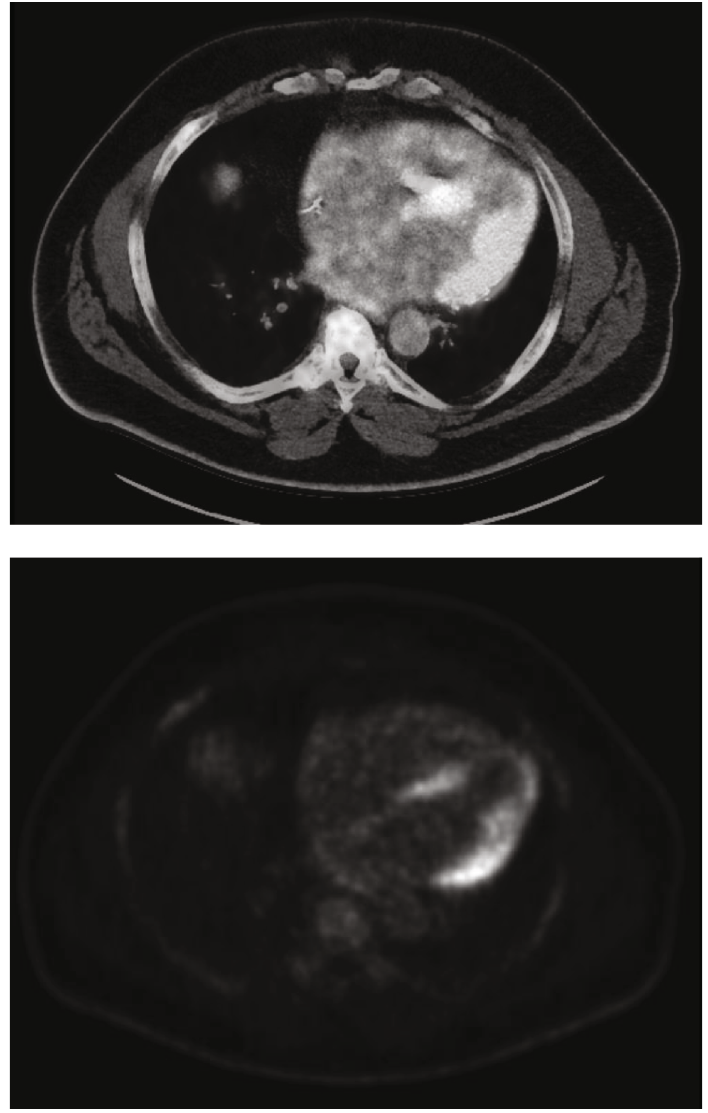
Figure 2: Active sarcoid seen in myocardium on FDG PET CT. FDG PET CT showing abnormal uptake in the myocardium as well as apical inferior wall with sparing of the apex with no extracardiac FDR